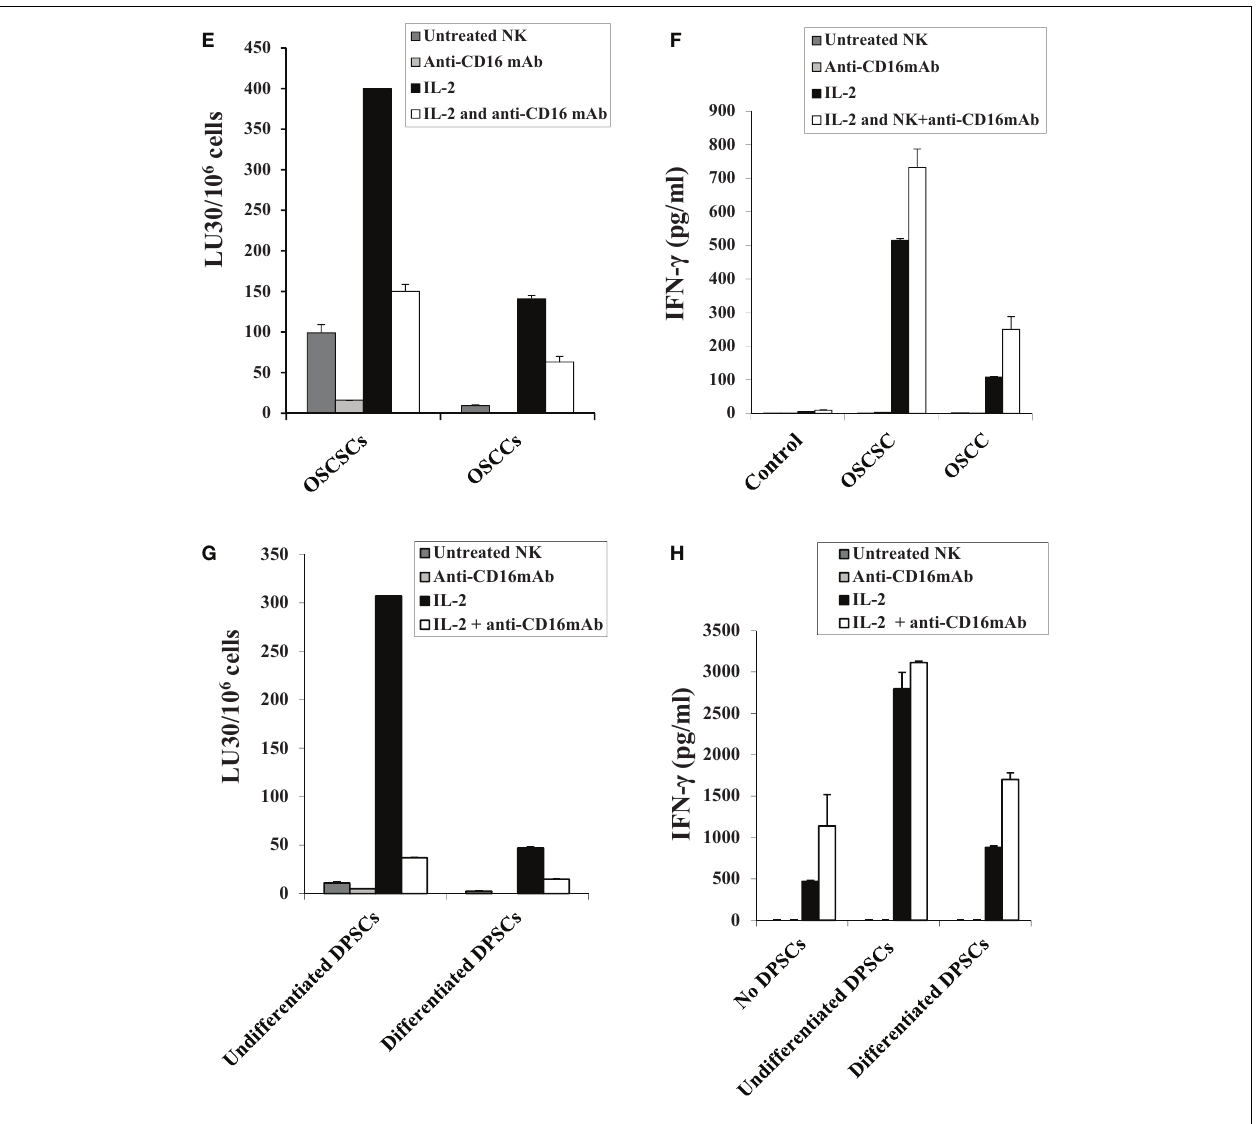
the absence or presence of OSCSCs and OSCCs (F) or undifferentiated and differentiated DPSCs (H) at an NK cell to target cell ratio of 0.5:1. After an overnight incubation, the supernatant was removed from the co-cultures and the levels of IFN- γ secretion were determined using specific ELISAs. One of minimum three representative experiments is shown in each of (B–H)